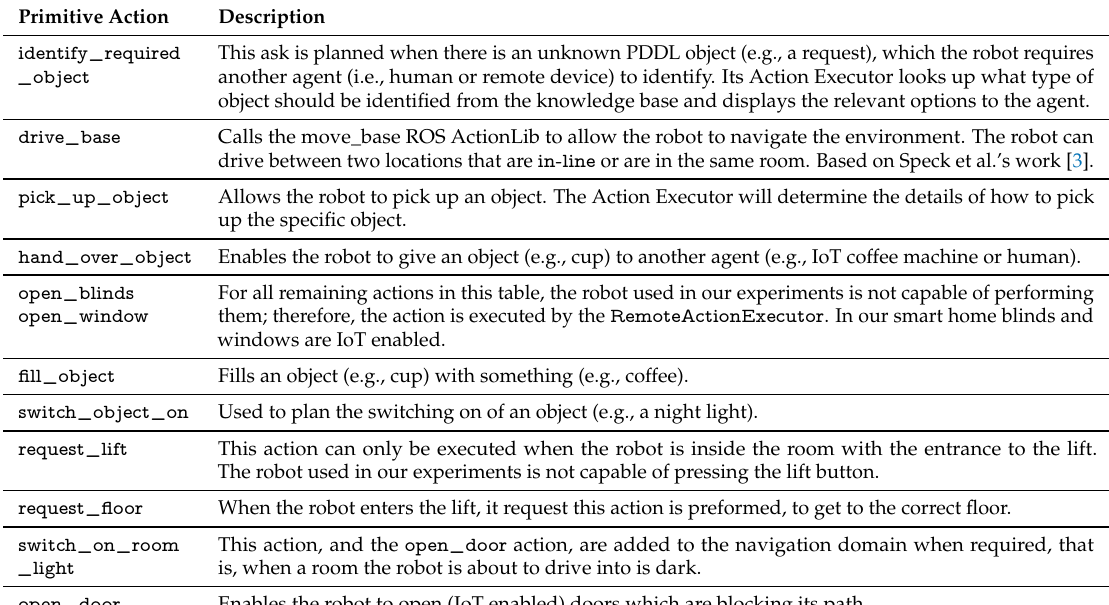
Table A2. Description of primitive